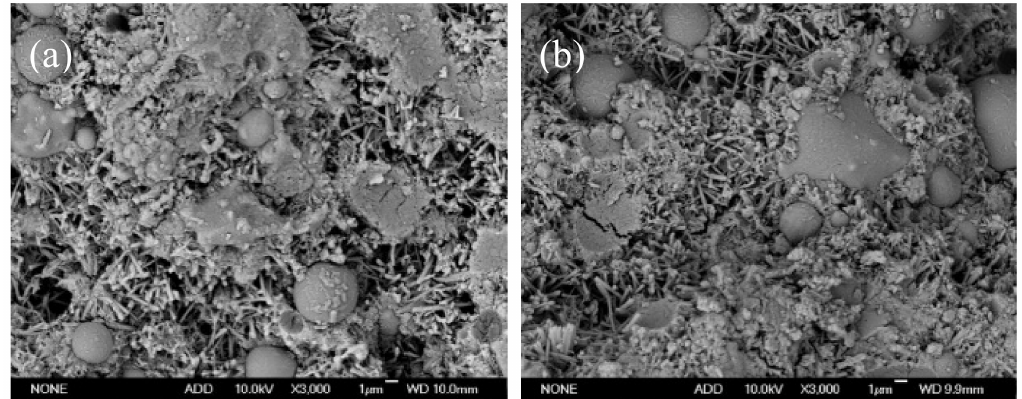
Figure 5. SEM photo of F1 and F3 groups with high fly ash content at 7 d: ( a ) F1, ( b )